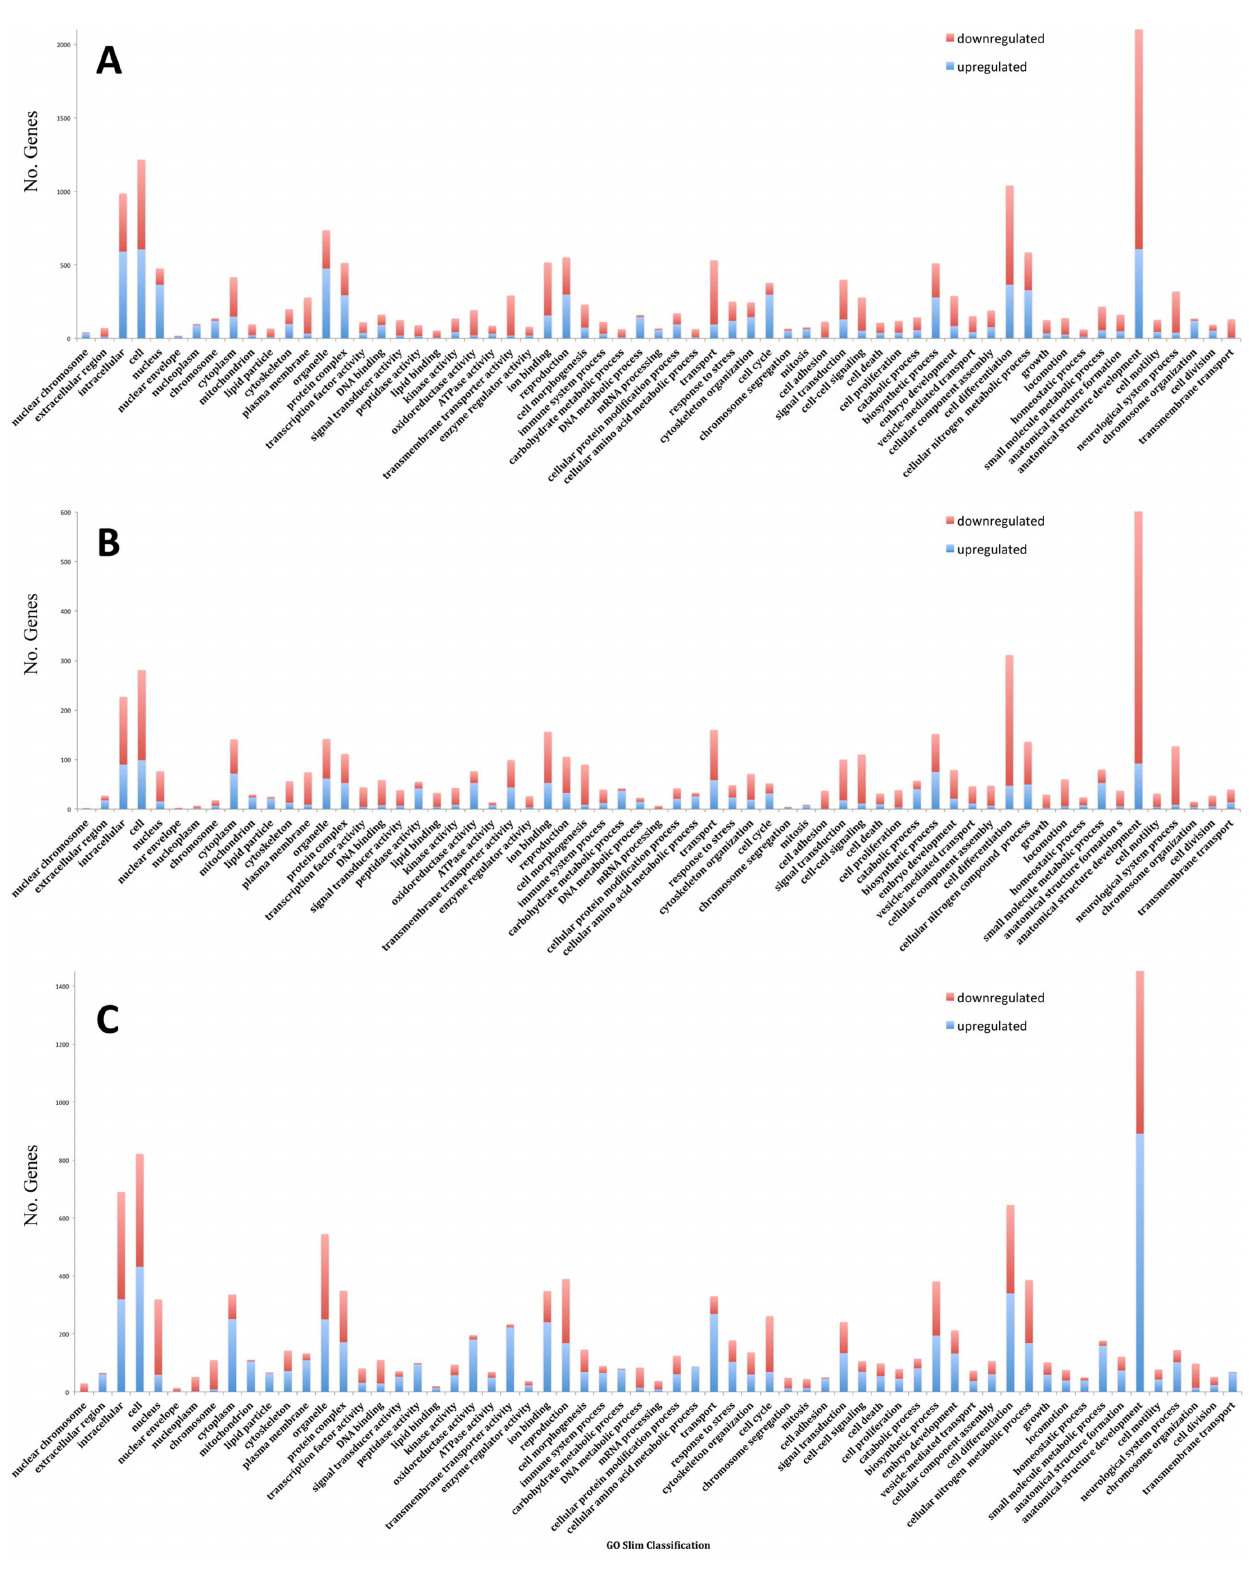
Figure 8. Transcriptional response to blood feeding in female Culicoidessonorensis . Numbers of genes classified within GO-slim categories that were upregulated (blue) or downregulated (red) in response to blood feeding are shown, including comparisons of (A) teneral versus an early blood meal (B) teneral versus an late blood meal, and (C) early blood meal versus late blood meal. Note difference in vertical scale between A, B and C.